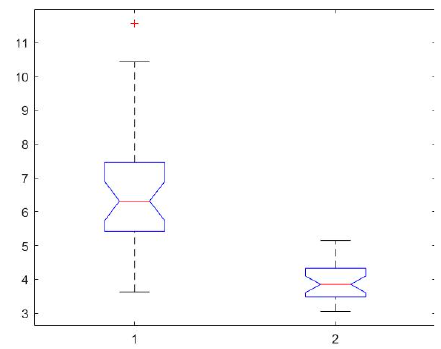
Figure 16. ANOVA test, MAPE indicator. 2. F 1 indicator. The result indicates a dissimilarity between the F 1 values, the one cor- responding to the proposed method being far better.